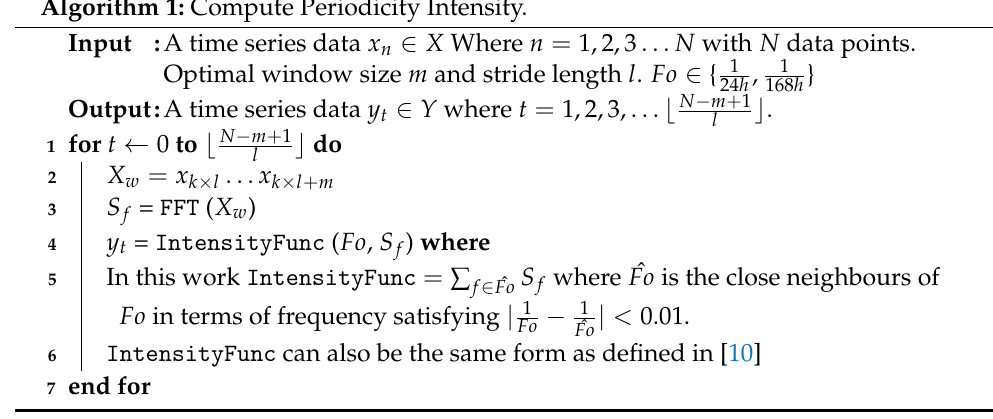
Algorithm 1: Compute Periodicity